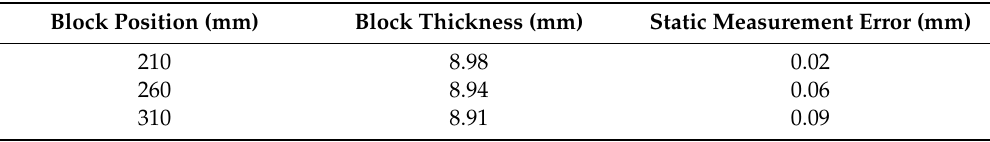
Table 1. Laboratory static measurement precision.